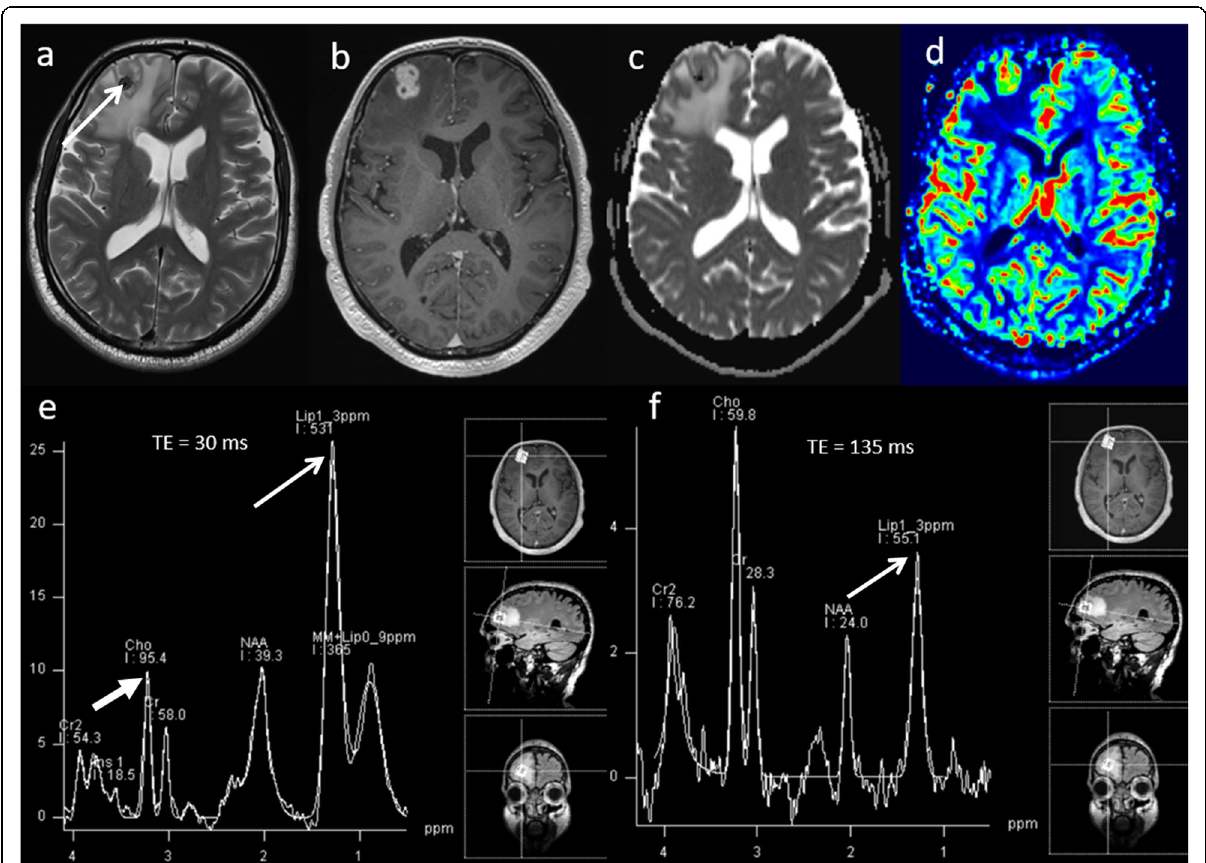
Fig. 13 Tuberculoma. Conventional MRI Findings: a , b Axial T2W and post-contrast T1W sequences show T2W hypointense confluent lesions in the right frontal lobe with extensive perilesional oedema and enhancement. Multiparametric MRI: c ADC map shows intermediate values (900 × 10 − 6 mm 2 s − 1 ), ( d ) PWI shows perfusion higher than the contralateral white matter, ( e , f ) MRS shows very high levels of lipid at 1.3 ppm (thin arrows), without any lactate. There is slightly elevated Cho/Cr ratio (1.5) on short TE MRS (thick arrow), moderately low NAA/Cr ratio and absence of mI. In this case of tuberculoma, the combination of a T2W hypointense lesion, raised rCBV, raised lipids and moderately increased Cho/Cr ratio helped to make the diagnosis. The patient commenced anti-tuberculosis treatment, and surgical intervention was